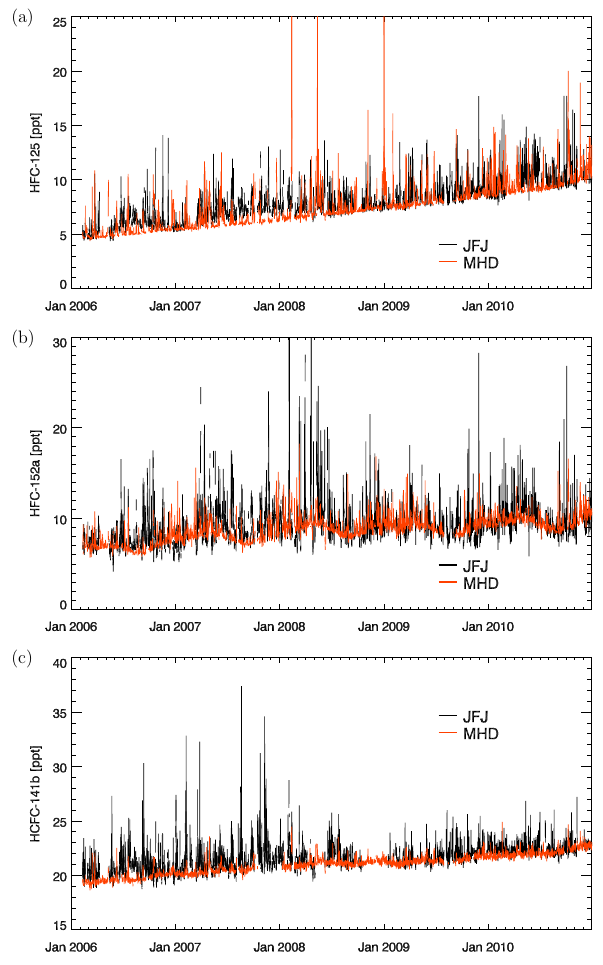
Fig. 1. Time series of (a) HFC-125, (b) HFC-152a, and (c) HCFC- 141b measured at Jungfraujoch (black) and Mace Head (red) during the five years 2006 to 2010.